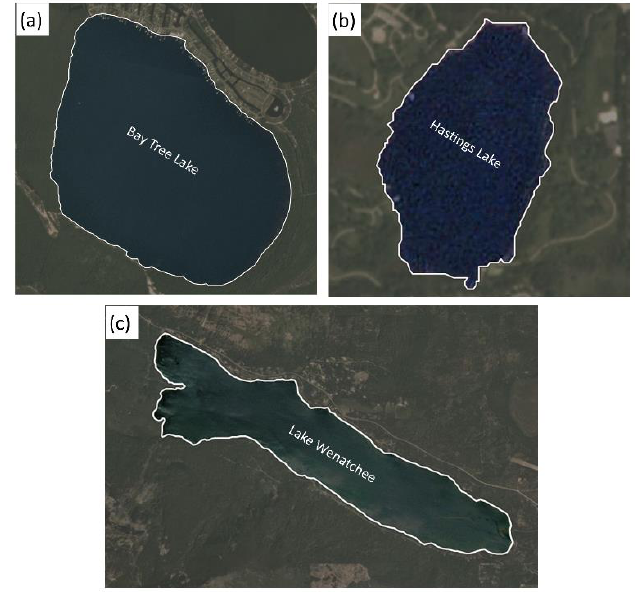
Figure 5. Examples of lake surface area validation and Planet imagery in ( a ) a simple case, Bay Tree Lake on 21 July 2017, ( b ) a case with a small lake, Hastings Lake on 24 November 2019, and ( c ) a case with topographic shadow, Lake Wenatchee on 2 June 2019. The white line is the manually delineated lake shoreline. Everything inside of that boundary is considered water. Surface areas of ( a ) 5.88 km 2 , ( b ) 0.29 km 2 , and ( c ) 9.68 km 2 were calculated.